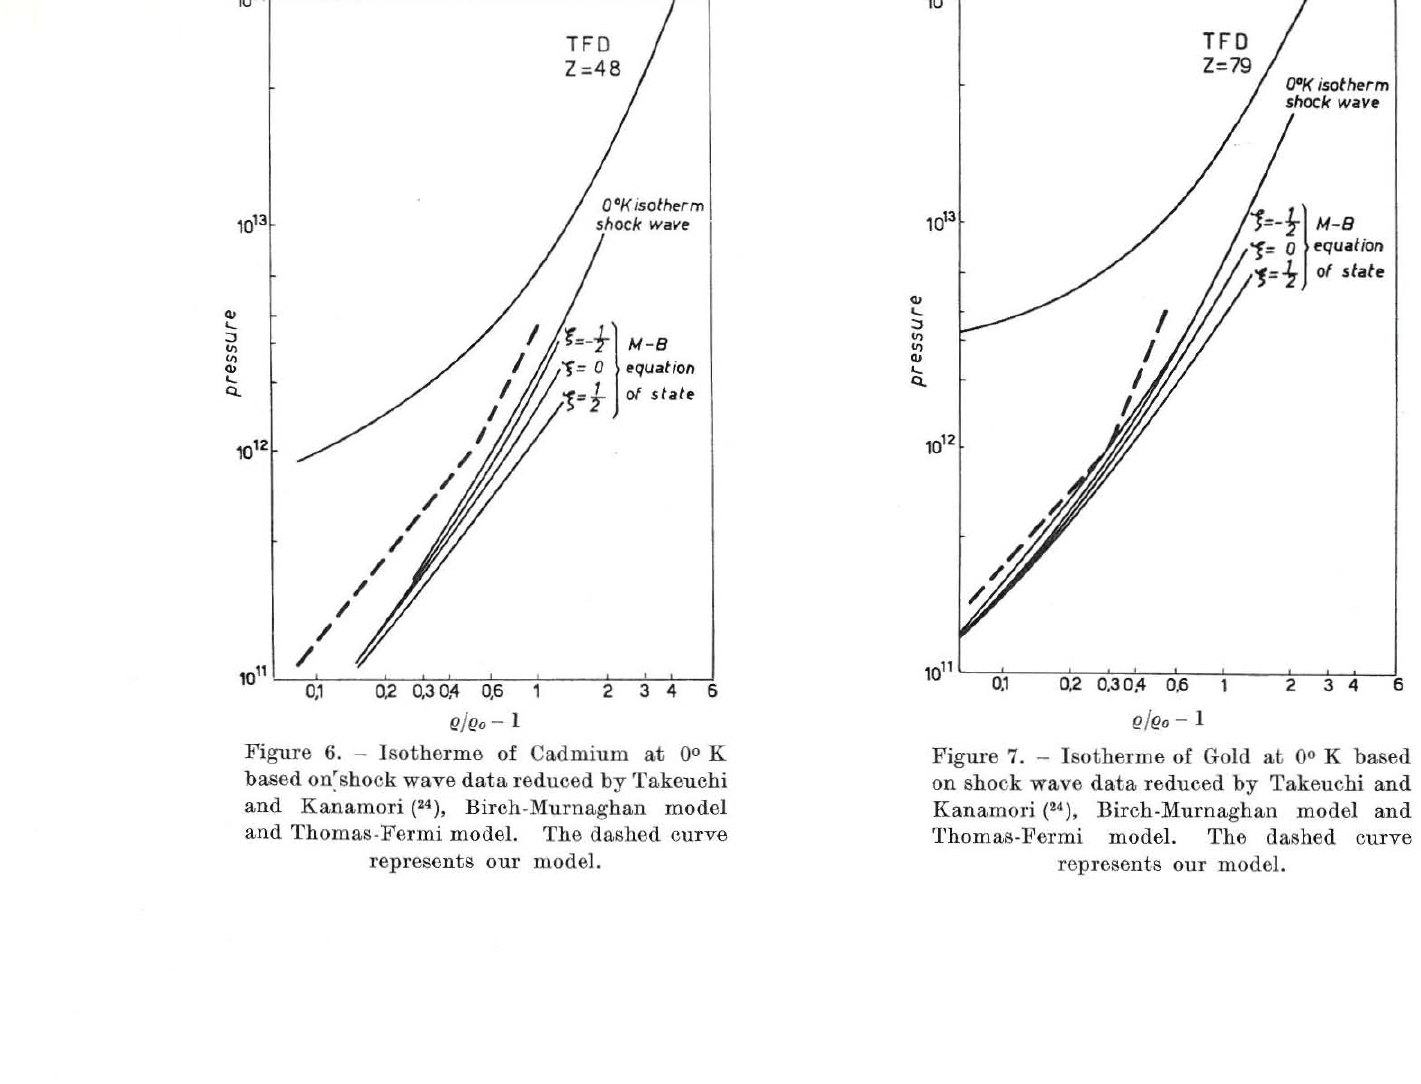
Figure 6, - Isotherme 01 Cadmium at 0 0 K based on~ shock wave data reduced by Takeuchi and Kanamori (24), Birch-Murnaghan modei and Thomas-Fermi fiodel. The dashed curve represents our model.